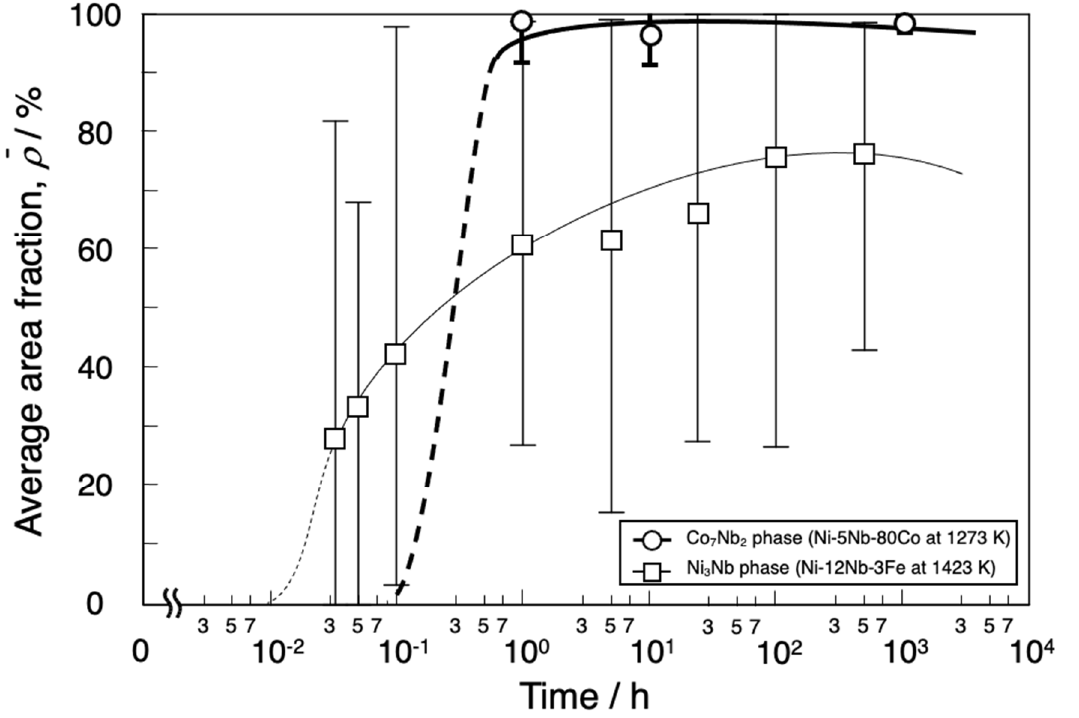
Figure 3. Change in the average area fraction of the Co 7 Nb 2 phase on the GB in Ni-5Nb-80Co aged at 1273 K, together with data for the Ni 3 Nb phase in Ni-12Nb-3Fe aged at 1423 K [23].